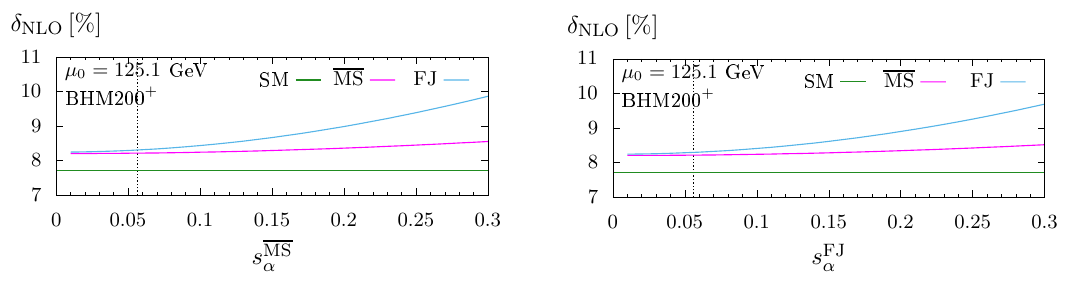
Figure 13 . s (cid:11) dependence of the relative EW+QCD NLO corrections to the decay width (cid:0) h ! 4 f . Free parameters other than s (cid:11) are (cid:12)xed according to benchmark scenario BHM200 + (see table 2). The vertical dashed line signals that for s (cid:11) . 0 : 06 perturbativity problems might